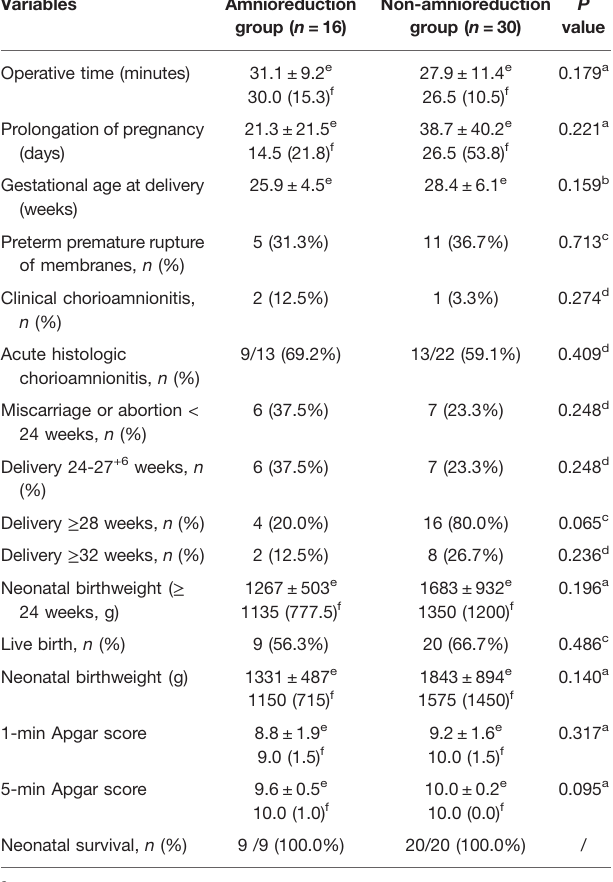
TABLE 2 | Clinical outcomes after surgery between amnioreduction group and non- amnioreduction group.